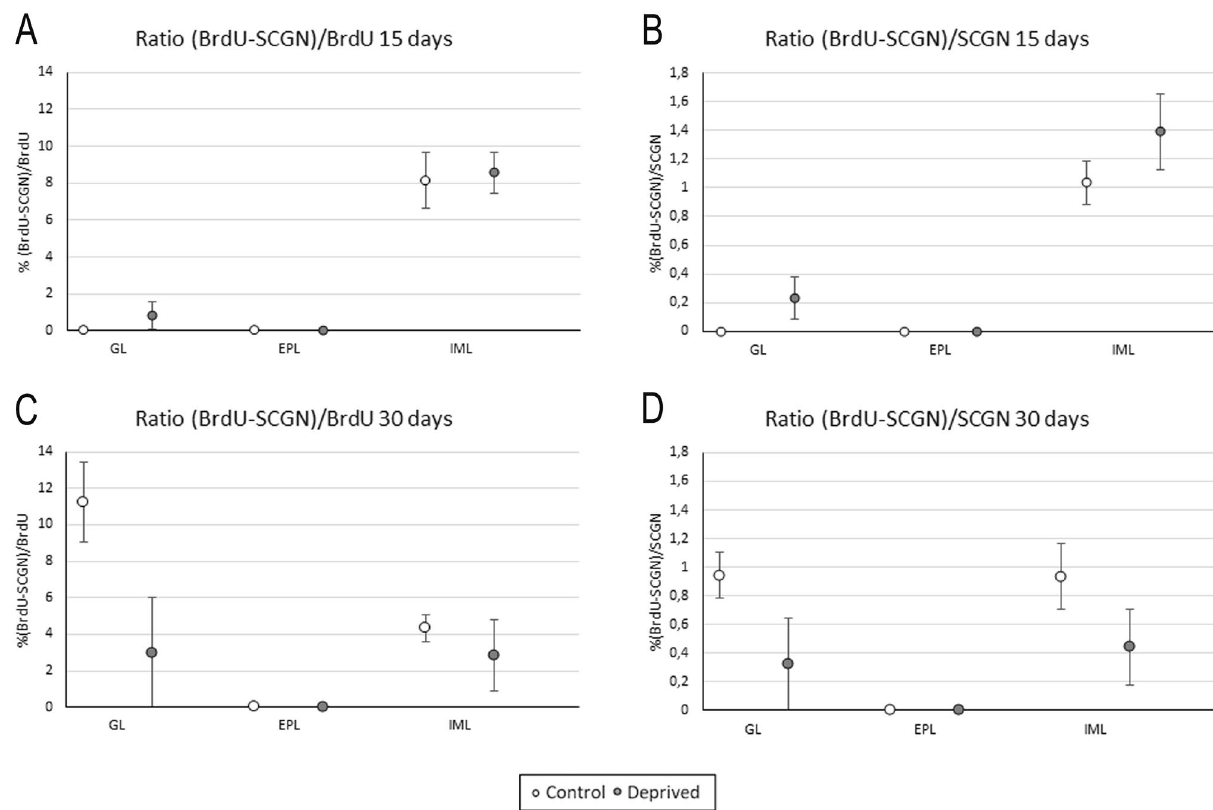
Figure 5. Quantification of BrdU-positive cells 15 ( A , B ) and 30 ( C , D ) days after BrdU administration in control (white) and deprived (gray) mice. ( A ) and ( C ) represent the ratio of doubly labeled cells in relation to the total BrdU-positive elements, that is, the cells that differentiate into SCGN-expressing neurons; ( B ) and ( D ) represent the ratio of cells doubly labeled in relation to the total SCGN-positive cells, which indicates how many cells of the total population of SCGN are newly formed. Analyses showed no statistically significant